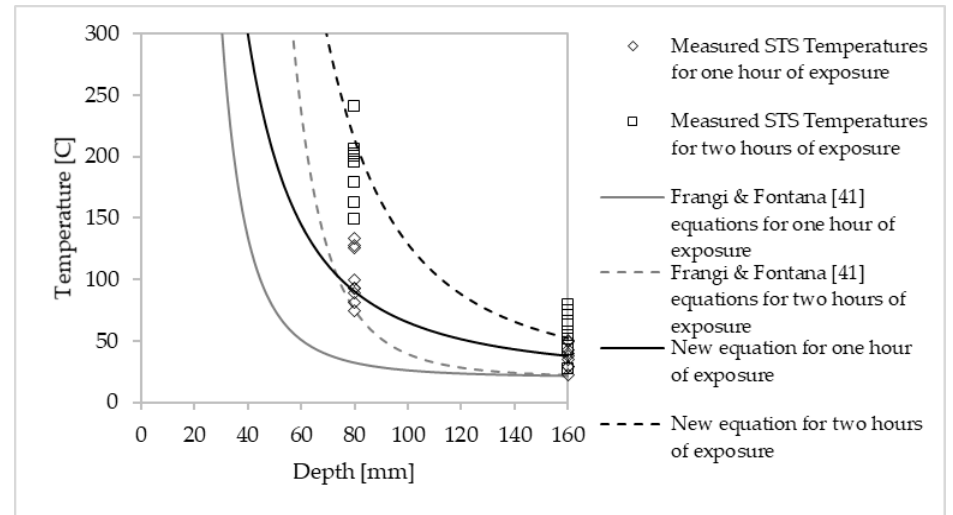
Figure 14. Temperature profiles using Equation (9) compared to that of Equation (6) and test data for STS with unprotected heads and exposed to a constant heat flux.